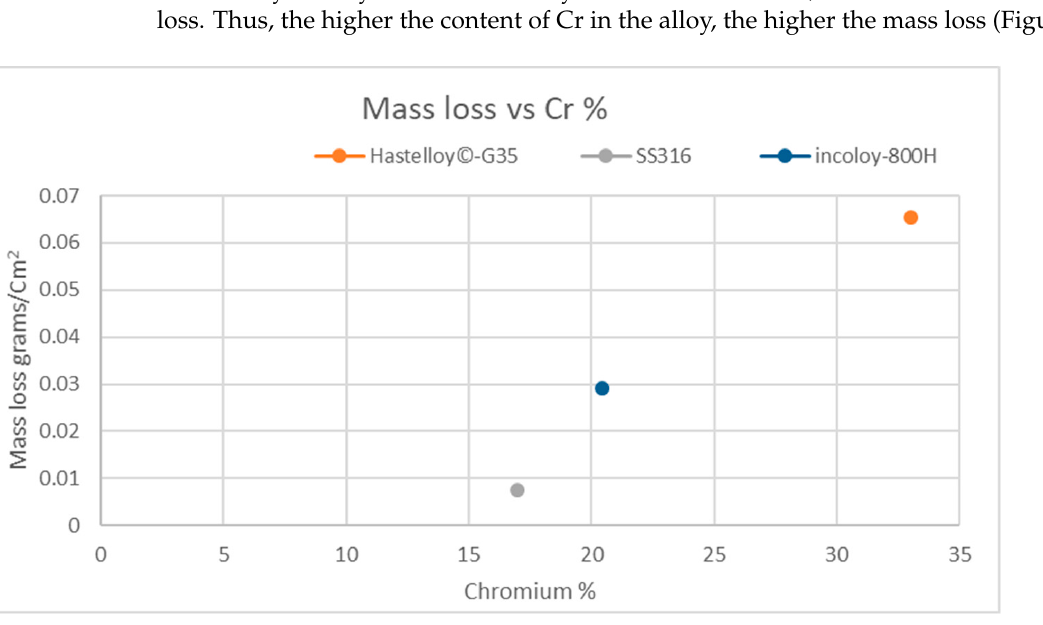
Figure 3. Graph showing that the mass loss in grams/cm 2 increases with Cr content in the samples.